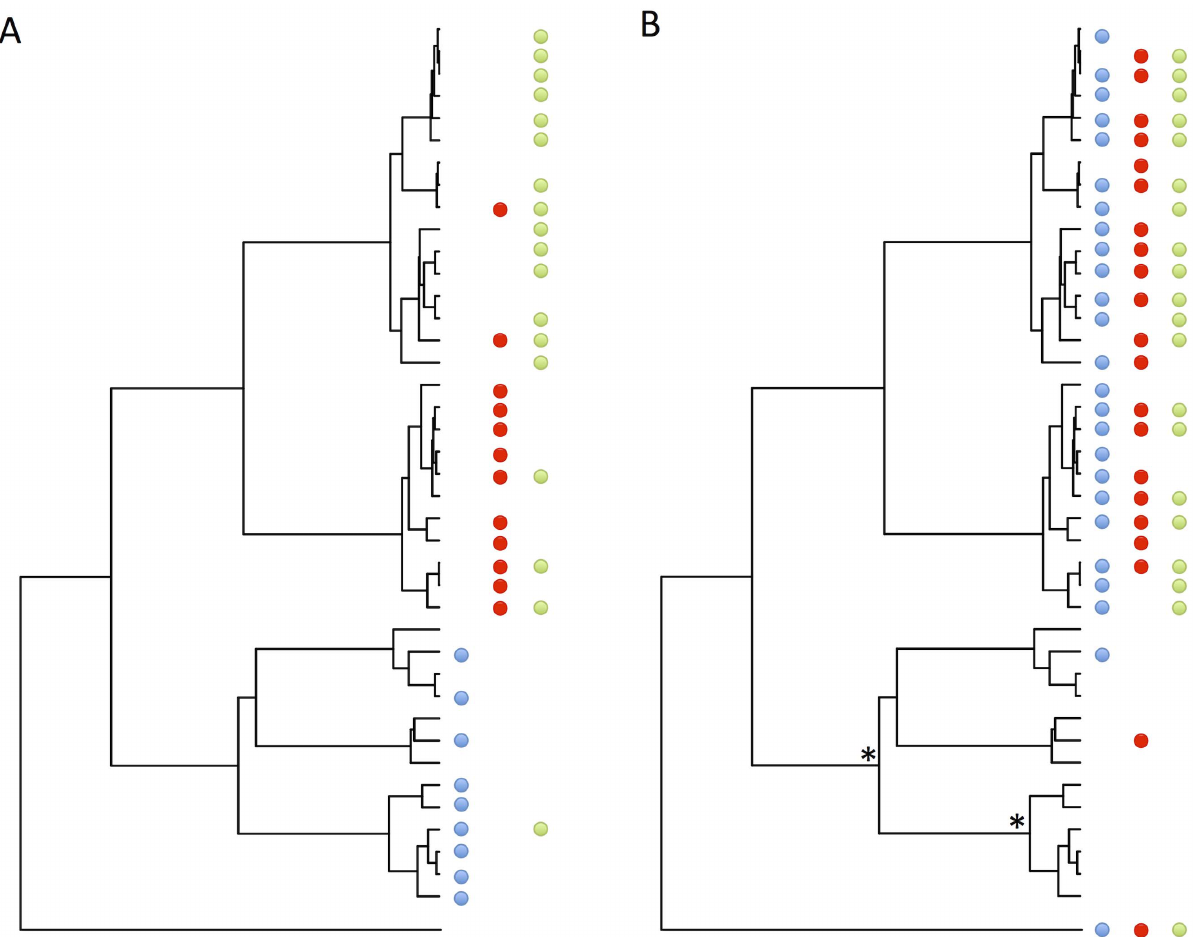
Figure 3. Examples of how patterns of host shifts can affect the distribution of pathogens across the host phylogeny. Each column shows the presence of a different pathogen, with a coloured circle representing the presence of that pathogen. In panel A, pathogens preferentially shift between closely related hosts, while in B closely related host species have similar levels of susceptibility to infection, regardless of the source of the pathogen (with two increases in host resistance occurring at the asterisks on the host phylogeny). Both processes result in closely related host species harbouring similar pathogens, and in some host clades harbouring more pathogen species. However, in A, but not B, host species with more close relatives tend to have more pathogens. For example, the phylogenetically isolated species at the bottom of the tree is not infected by any of the three pathogens in A, but is in B.